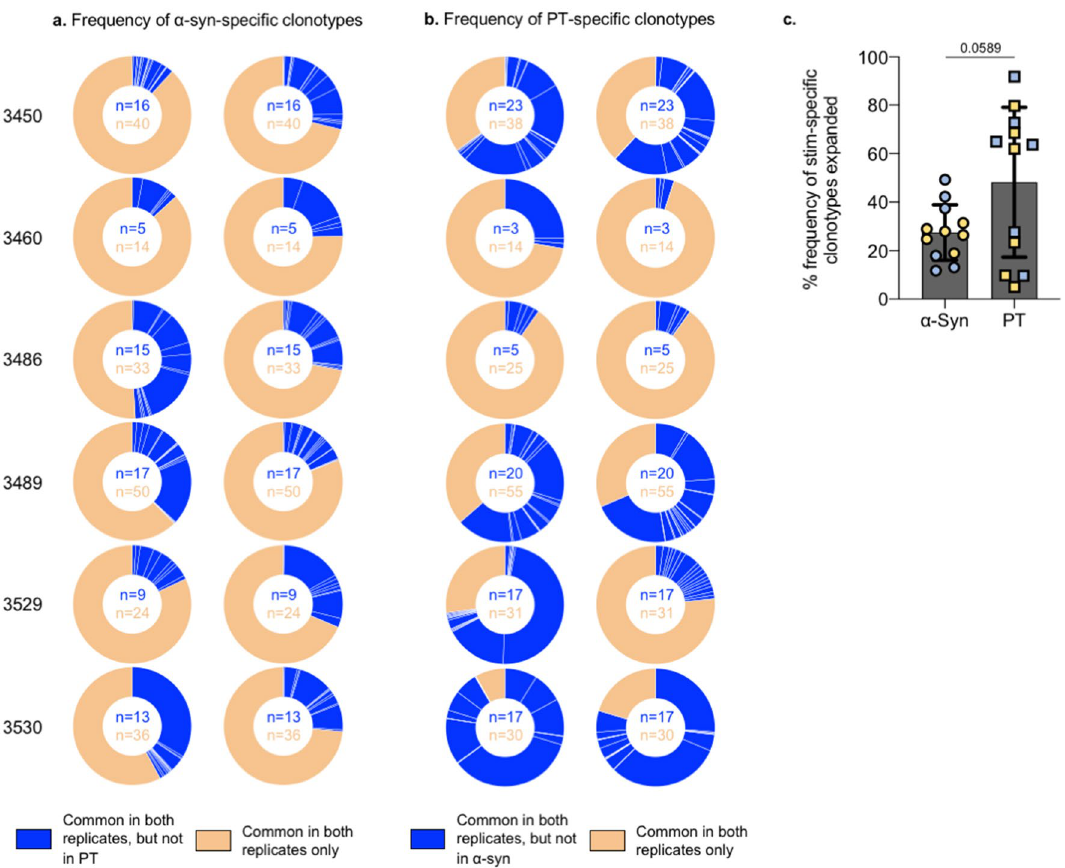
Figure 4. α-Syn-specific clonotypes have a similar frequency to the overall expanded clonotypes. Frequency of clonotypes expanded upon α-syn ( a ) or PT ( b ) stimulation in both replicates (excluding non-specific expansion in response to both stimuli conditions) in the total productive repertoire (normalized to respective combined total) in individual PD participants. c Percentage frequency of the expanded antigen-specific clonotypes for α-syn and PT. Yellow and blue indicates individual replicates. Mean ± StDev is shown. Paired two-tailed